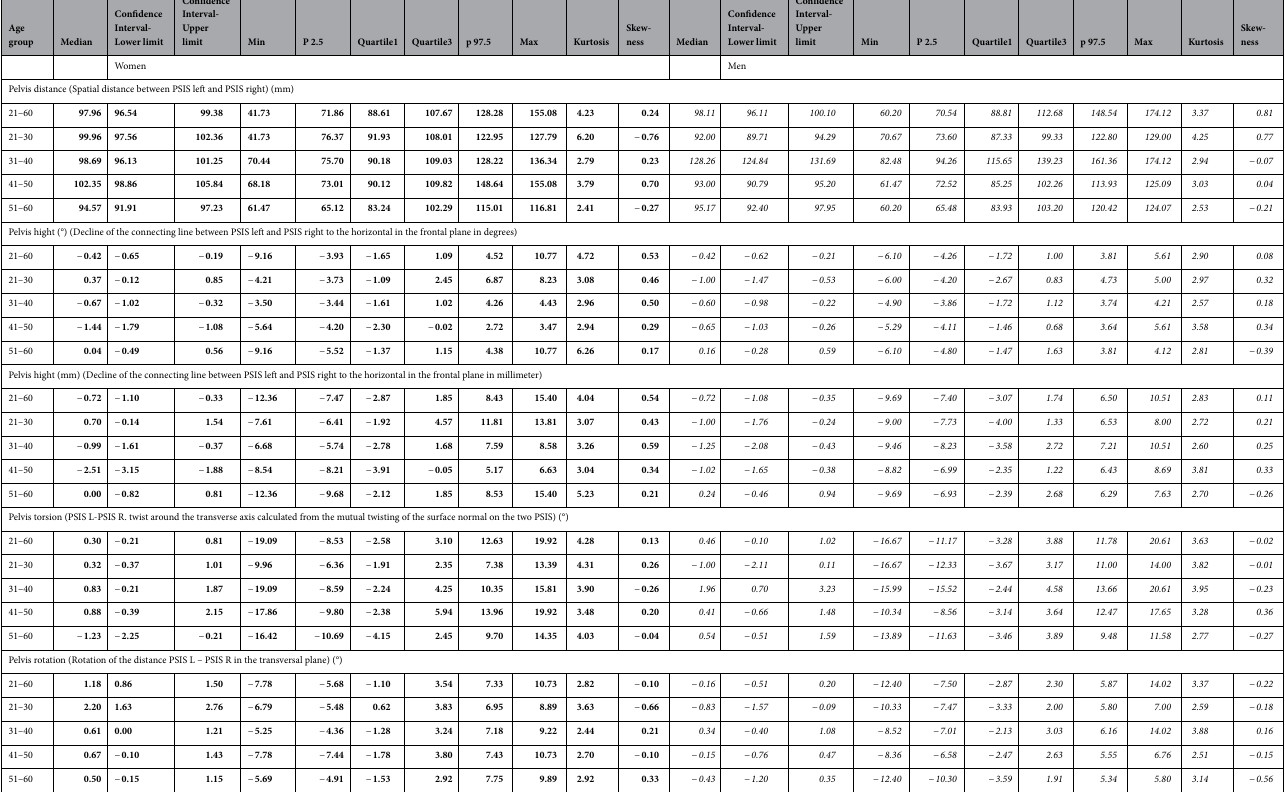
and Table 4 for the pelvis parameters. A test on the normal distribution revealed that a few of the subgroups were not normally distributed. This can also be seen when looking at the kurtosis and skewness parameters. However, for the majority of the variables, the kurtosis was around 3 for most age and gender subgroups, while the skewness was around 0. A description of the upper body posture for each sex, summarized from the results of the four age groups (21–30, 31–40, 41–50 and 51–60 years), is given below. Tables 2, 3, 4.